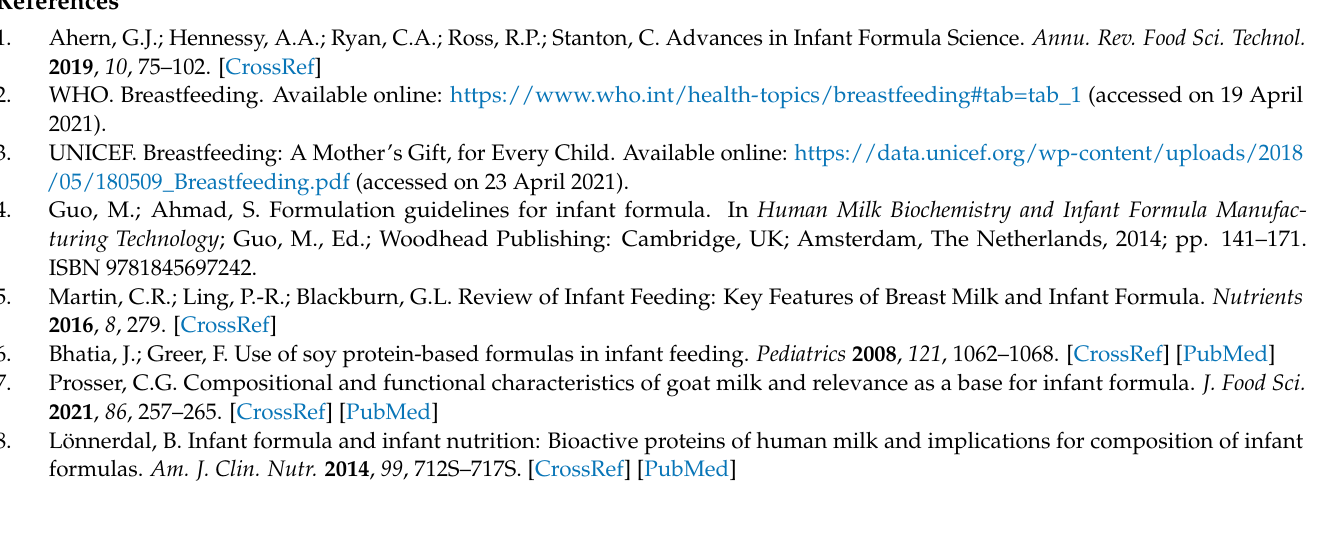
human milk, Figure S4: Sequence logo cleavage sites of β -casein, Figure S5: Distribution of the peptide length in β -casein and α S1 -casein, Table S1: Nutritional parameters of the analyzed IF title, Table S2: Donor-specific parameters, Table S3: List of chemicals, Table S4: List of native